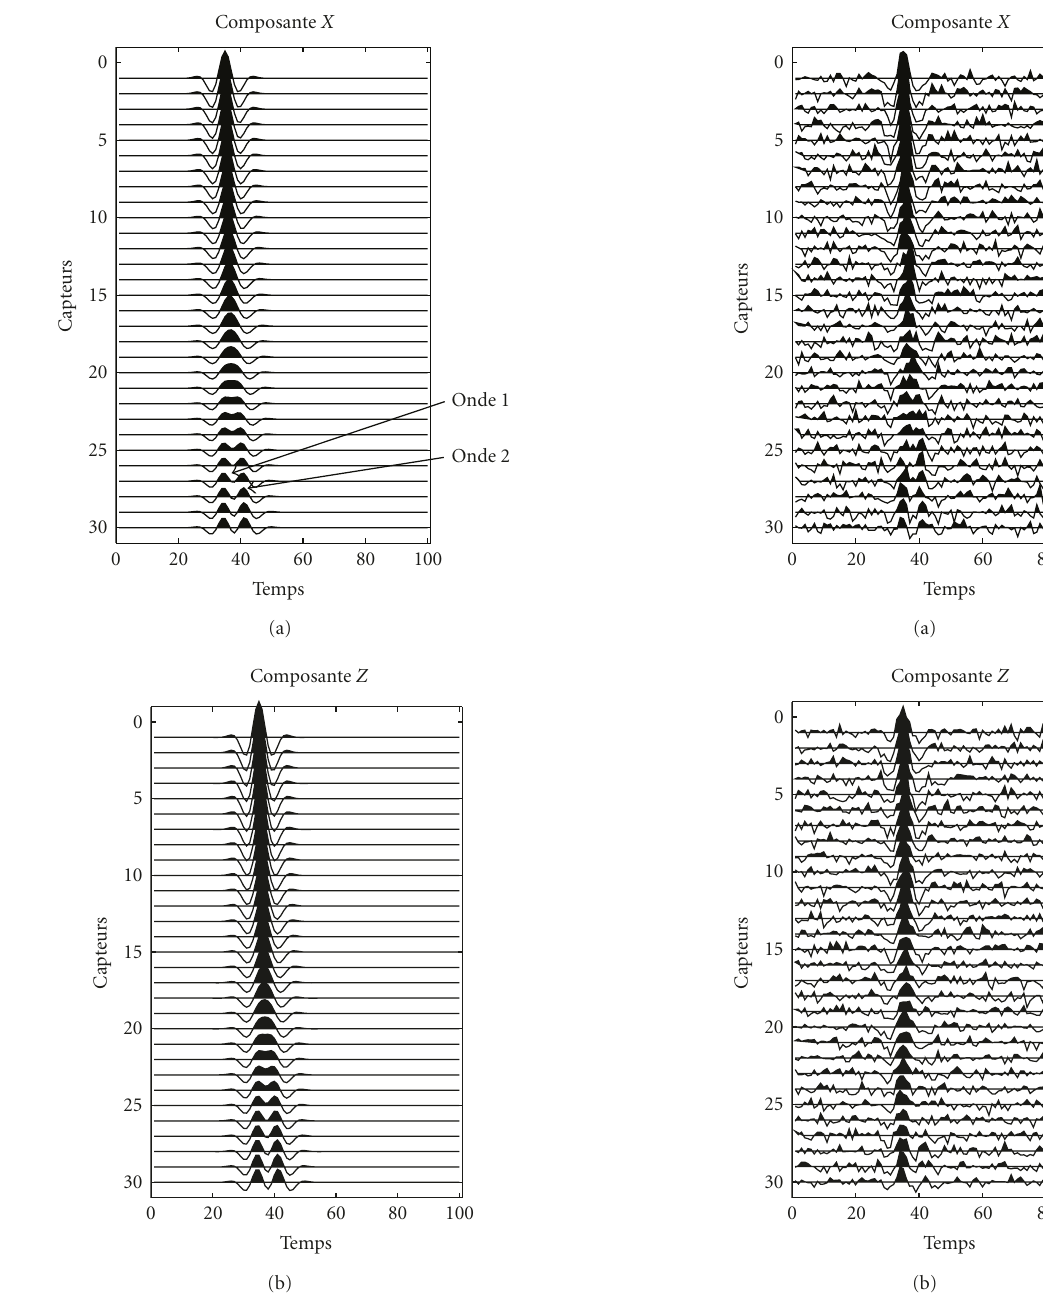
to estimate MWSM might a ff ect the wave amplitudes since smoothing is equivalent to an averaging in distance over a small number of sensors.